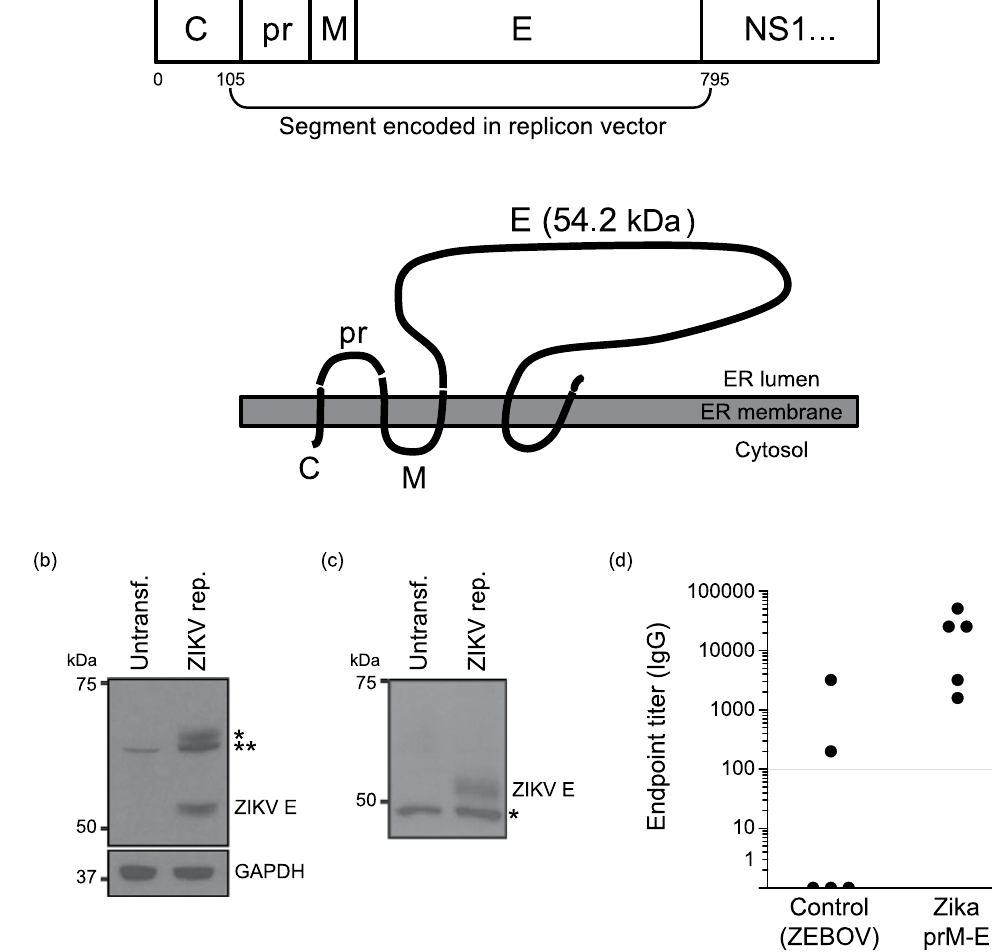
Figure 1. RNA nanoparticle vaccine design and function. ( a ) ZIKV polypeptide region encoded in the RNA replicon as the target antigen (numbers refer to amino acid positions), and predicted topology of the expressed truncated protein segment. ( b ) Immunoblot performed on lysates of replicon-transfected BHK21 cells 72 h post-transfection with an anti-ZIKV E rabbit polyclonal antibody. Asterisks indicate additional high-molecular weight bands possibly corresponding to incompletely processed E protein ( * ) or a combination of incompletely processed E protein and background band also present in untransfected control cells ( ** ). ( c ) Immunoblot performed as in ( b ) but on conditioned supernatant removed from transfected cells. The asterisk indicates a common background band presumably produced by cross-reactivity of the polyclonal antibody used for detection against a culture medium serum component. The membrane was cropped above the 75 kDa marker to eliminate contaminating bovine serum albumin (from the culture medium) bands from the blot. ( d ) Anti-ZIKV recombinant E protein IgG titers from C57BL/6 mice immunized with the indicated RNA nanoparticle